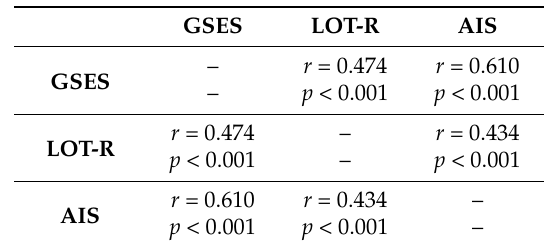
Table 6. Correlations between GSES, LOT-R, and AIS in the PCOS patients